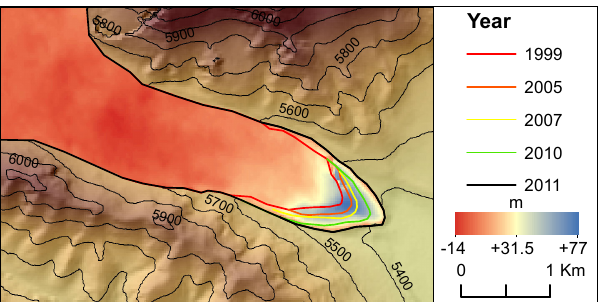
Fig. 6. Positive surface elevation changes in glacier tongue region of glacier 5Z213E0012 (World Glacier Monitoring Service id). DIn- SAR derived surface elevation changes are color-coded. In the back- ground is the TSX/TDX DEM. Glacier terminus positions are based on Landsat imagery. Location is shown in Fig.